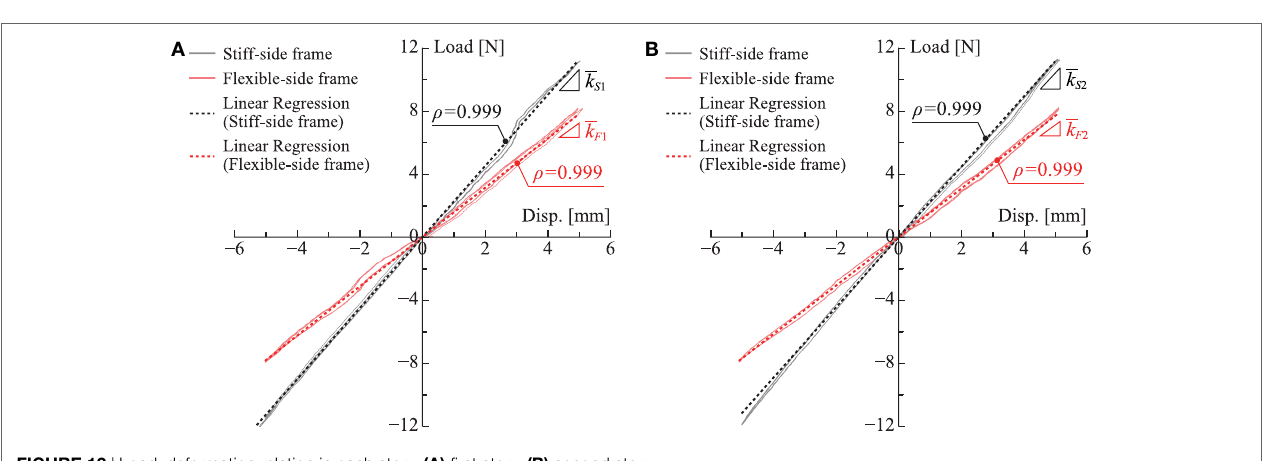
FIGURE 12 | Load–deformation relation in each story, (A) first story, (B) second story.